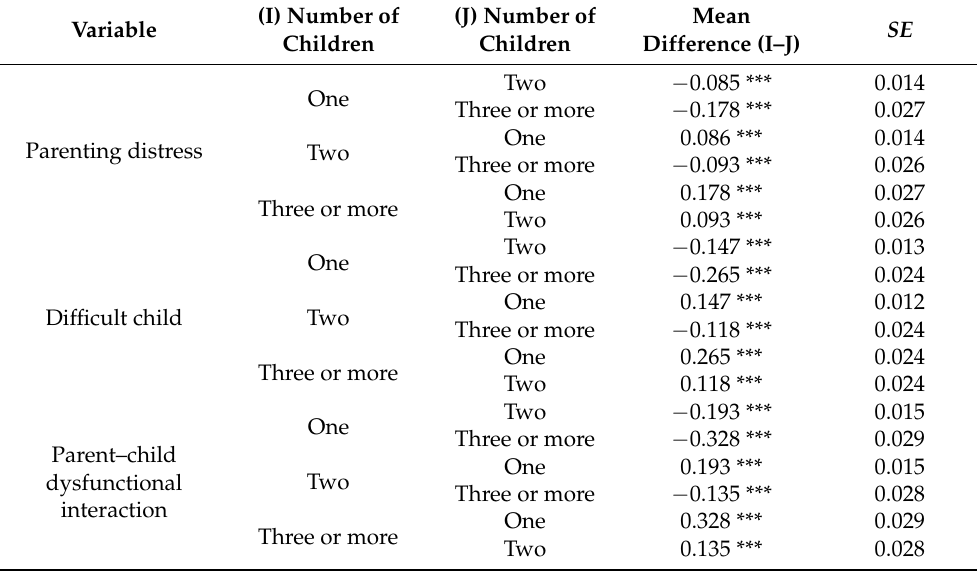
Table 2. Comparison of parenting stress with different number of